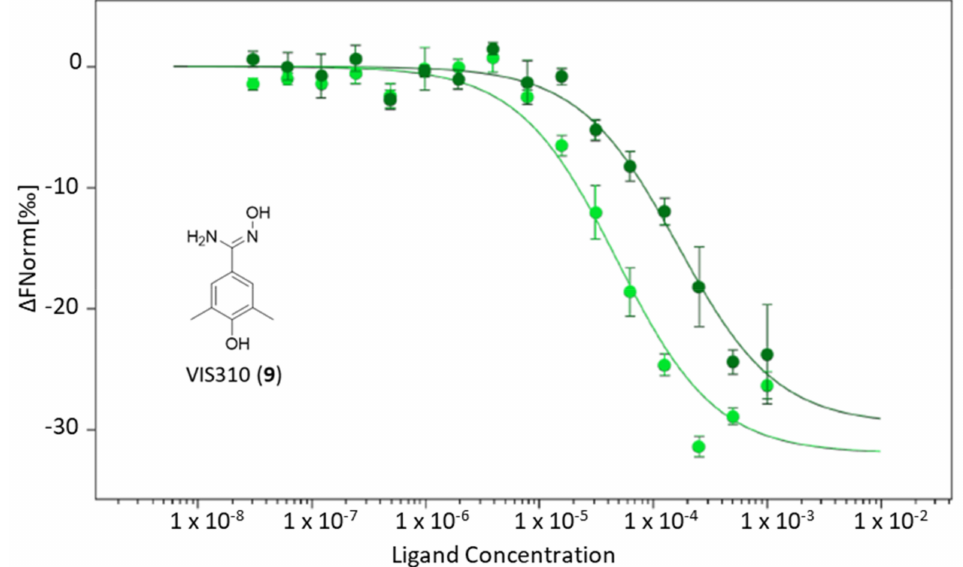
Figure 4. MST binding curves of VIS310 ( 9 ) to NT650/PD-L1 at pH 7.2 (dark green circles and line) and 6.2 (light green circles and